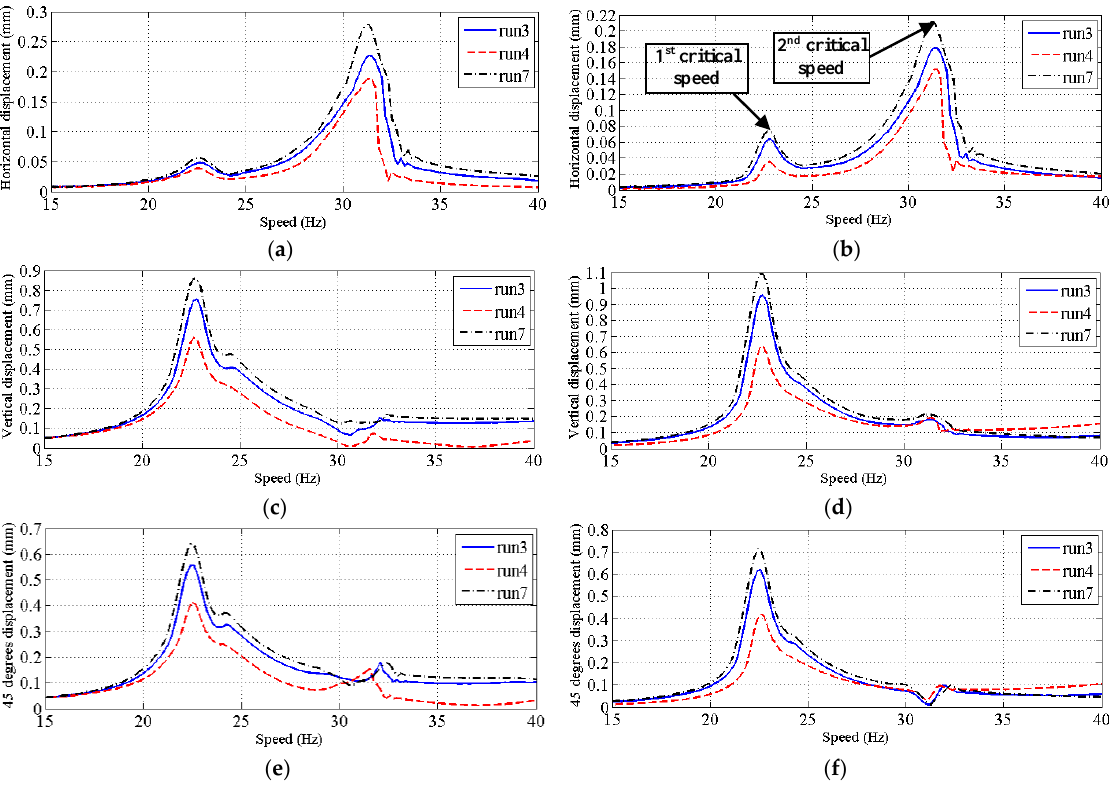
Figure 4. Typical measured 1× displacement responses in ( a ) B1 horizontal; ( b ) B2 horizontal; ( c ) B1 vertical; ( d ) B2 vertical; ( e ) B1 radial 45° and ( f ) B2 radial 45° for the experimental runs 3, 4 and 7.